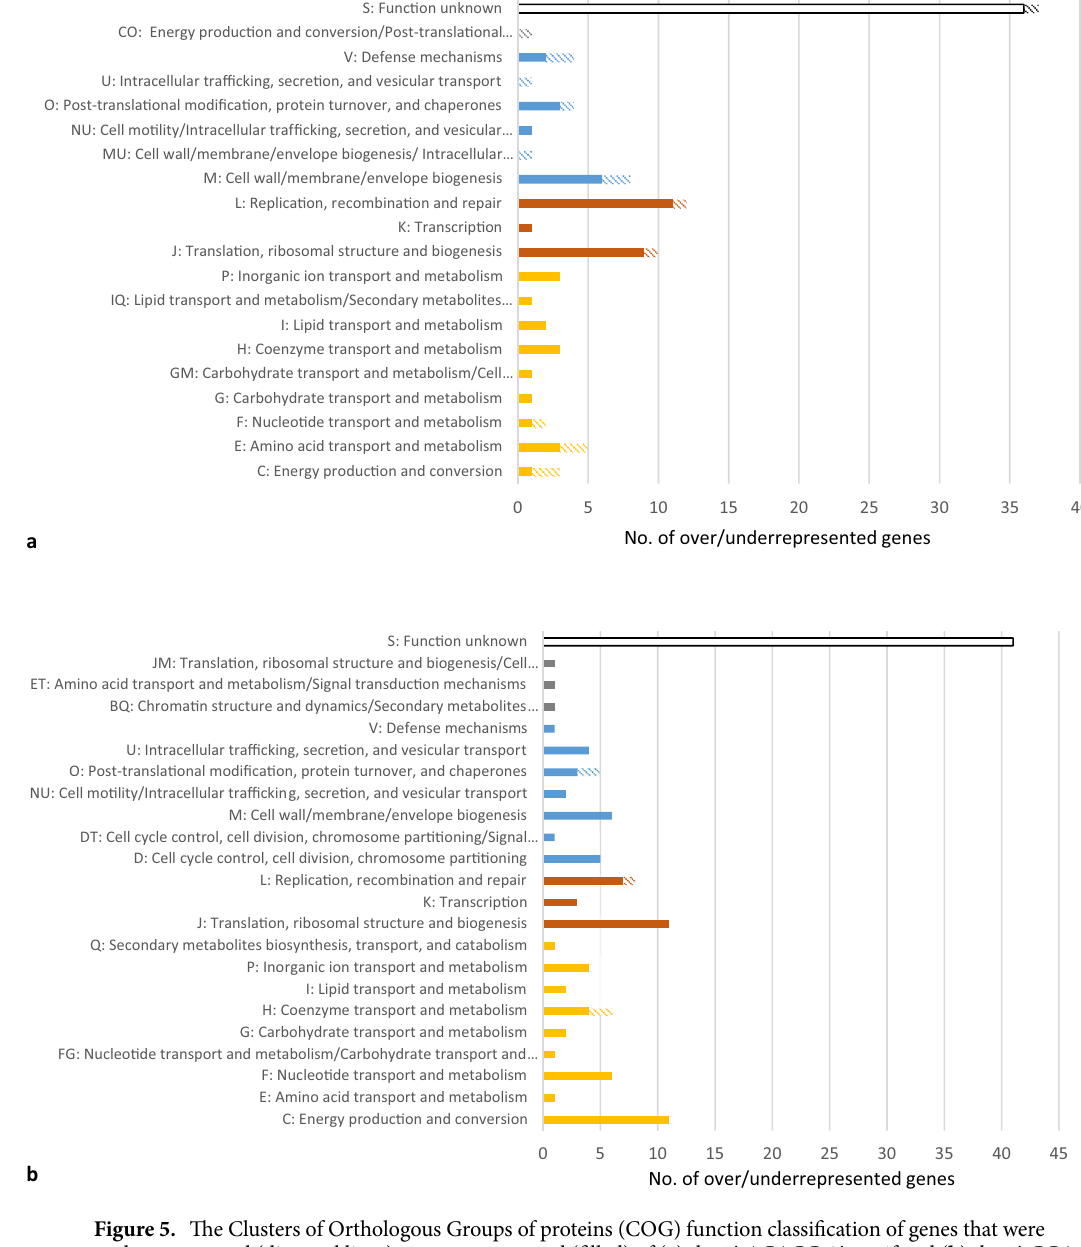
Figure 5. The Clusters of Orthologous Groups of proteins (COG) function classification of genes that were underrepresented (diagonal lines) or overrepresented (filled) of ( a ) the 5 ′ -ACACC-3 ′ motif and ( b ) the 5 ′ -CGA AT-3 ′ motif in the N. meningitidis 2013 strain and UK original strain. Yellow = metabolism, brown = information and storage processing, blue = cellular process and signalling, green = metabolism/cellular process and